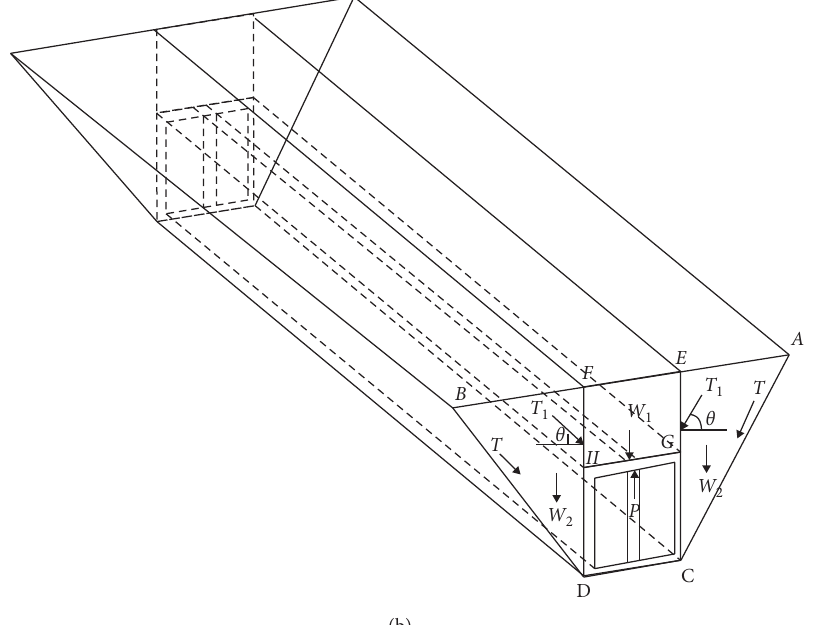
Figure 9: Calculation model of interaction between the utility tunnel and Earth in the hanging wall of ground fissure. (a) Structural overall diagram. (b) Structural hanging wall force